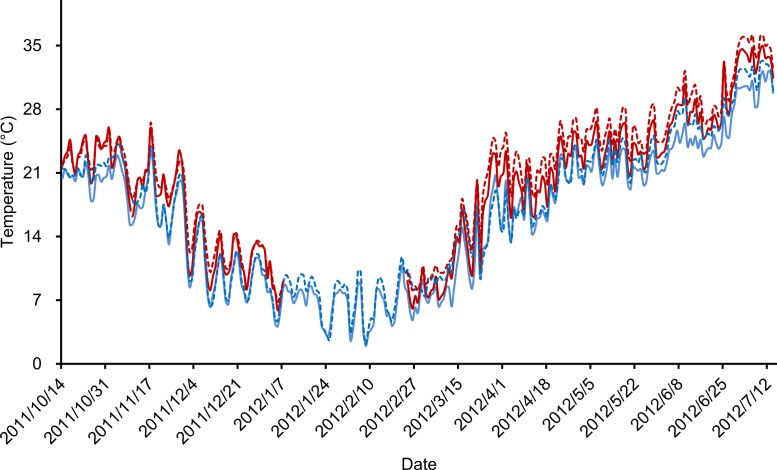
Daily average temperatures (°C) recorded during experimental period.Solid lines indicated the air temperature and dotted lines indicated the water temperature, blue color indicated ambient temperature treatments and red color indicated experimental warming treatments.